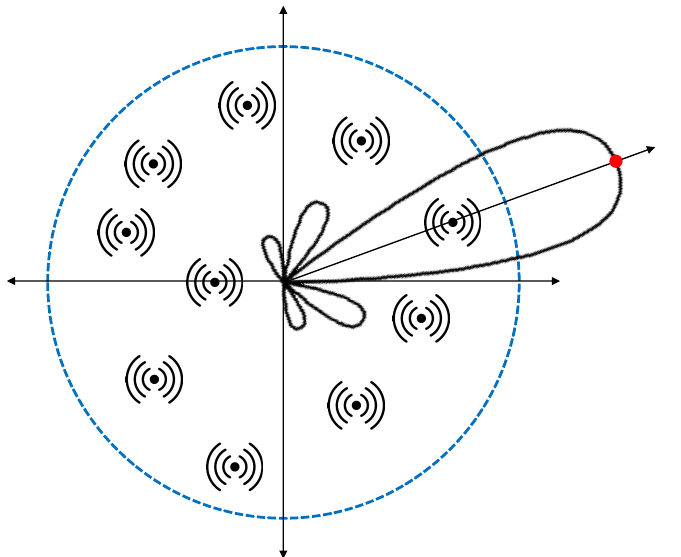
Figure 3. The concept of the collaborative beamforming (black dots: sensors; red dot: access point